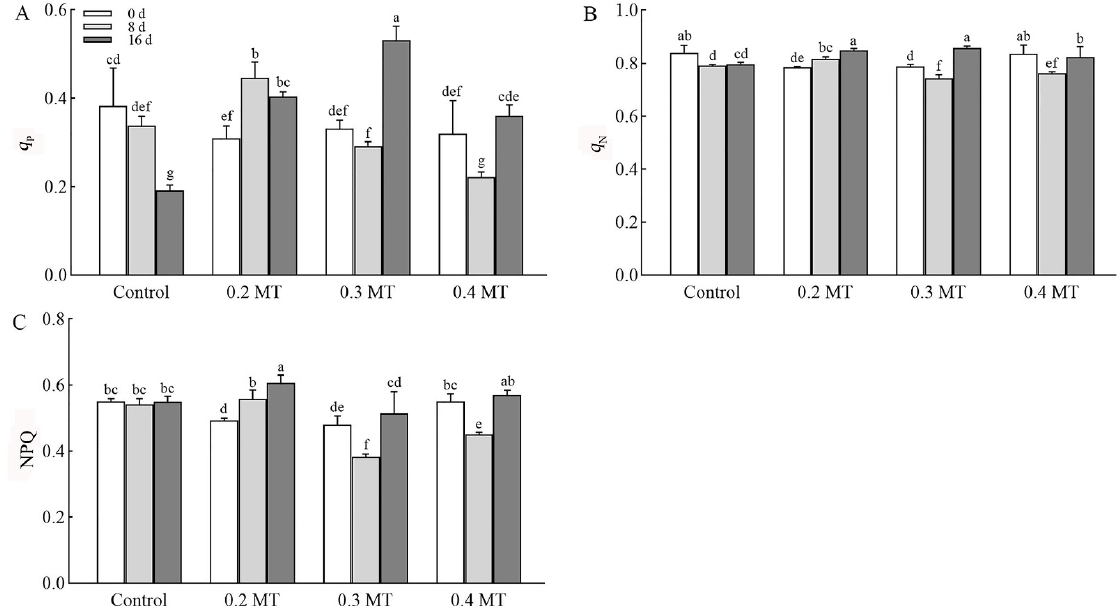
Figure 3. Effect of exogenous MT on Chl fluorescence quenching coefficients. ( A ) Photochemical quenching coefficient ( q P ): the share of light energy absorbed by PSII antenna pigment used for pho- tochemical electron transfer, reflecting the level of plant photosynthesis. ( B ) Non-photochemical quenching coefficient ( q N ) and ( C ) Non-photochemical quenching (NPQ): the thermal dissipation of excitation energy by PSII antenna pigment system, reflecting the thermal dissipation level of non- photochemical process. The difference between the two is that NPQ characterizes q N , and different calculation methods. Data are shown as means ± SD in three independent replicates. Different su- perscript letters indicate significant differences between different treatments at p < 0.05 level.